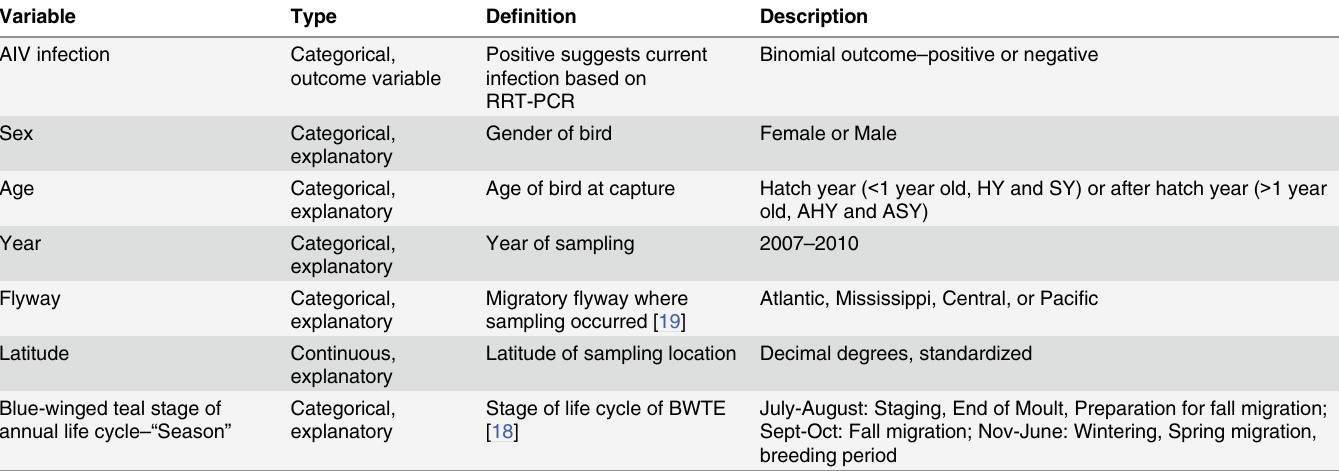
Table 1. List of outcome and explanatory variables used in models examining demographic and spatiotemporal determinants of low pathogenic avian influenza virus infection in Blue-winged Teal in Canada and the United States, 2007 –